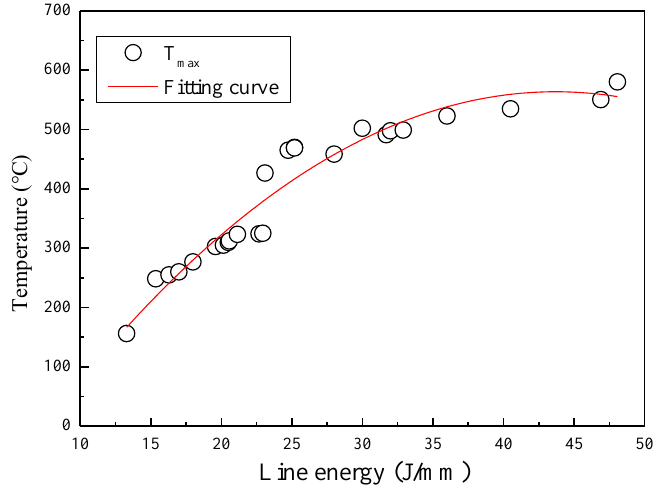
Figure 5. Variation in the maximum temperature of the PMMA – steel joint with varying line energy.